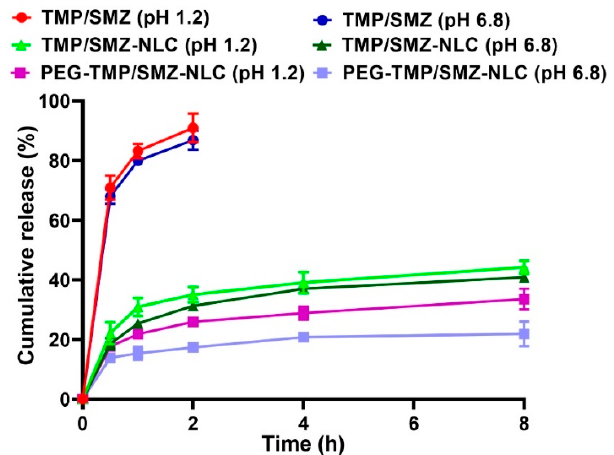
Figure 3. Cumulative drug release from TMP/SMZ solution, TMP/SMZ-NLCs, and PEG-TMP/SMZ- NLCs. As the figure shows, PEG-TMP/SMZ-NLCs, compared to TMP/SMZ-NLCs, caused a signifi- cant decrease in the amount of drug release ( p < 0.05). Results are expressed as mean ± SD of three independent experiments.